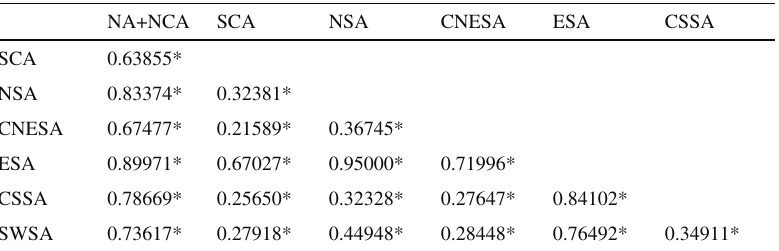
Table S5 - Pairwise Ф st values among seven major groups of Puma concolor , estimated on the basis of p-distances (see text for